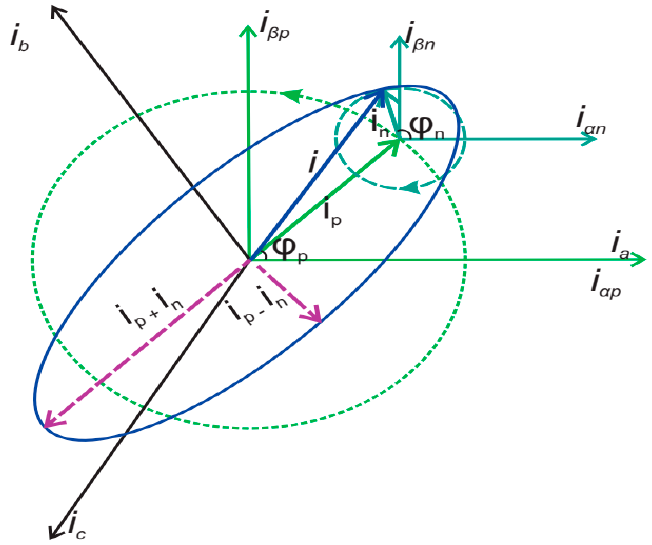
Figure 9. Phasor diagram for the resultant current and its sequence components [5] .